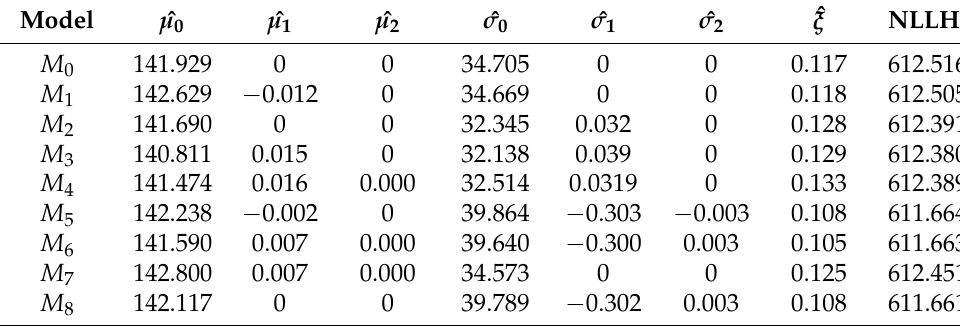
Table 7. Non-stationary GEVD models for Gauteng for the period